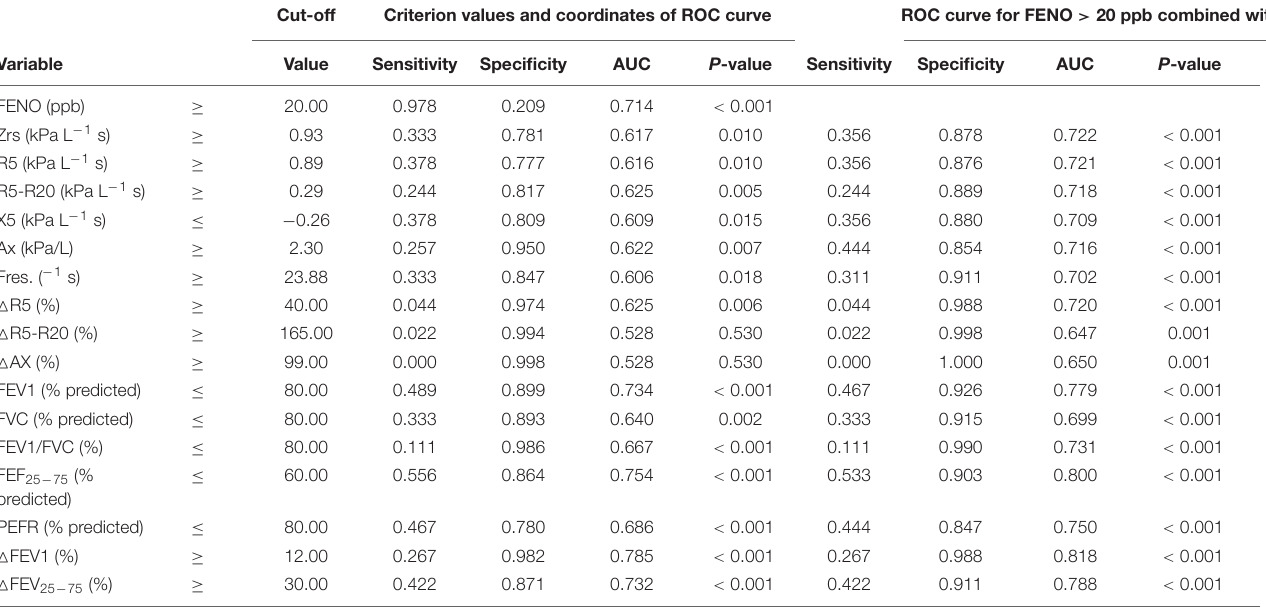
TABLE 5 | Predictive values for uncontrolled asthma among asthmatic children between FENO, IOS, and spirometry measurements. Cut-off Criterion values and coordinates of ROC curve ROC curve for FENO > 20 ppb combined